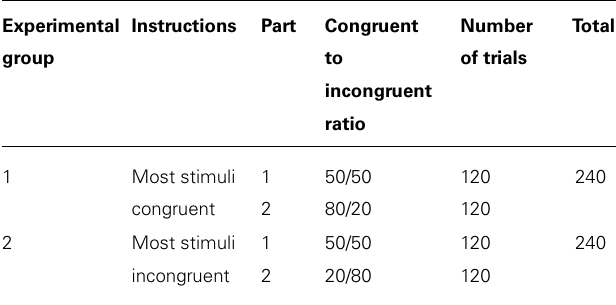
Table 1 | Experimental design.